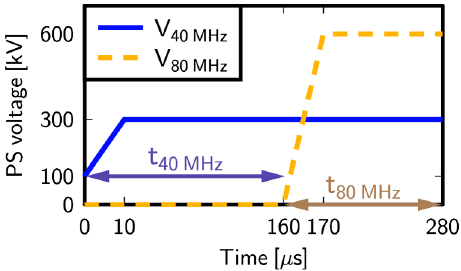
FIG. 2. Currently operational PS bunch rotation voltage pro- gram [3]. The voltage is produced with one 40 MHz and two 80 MHz cavities; the two rf systems are in phase.